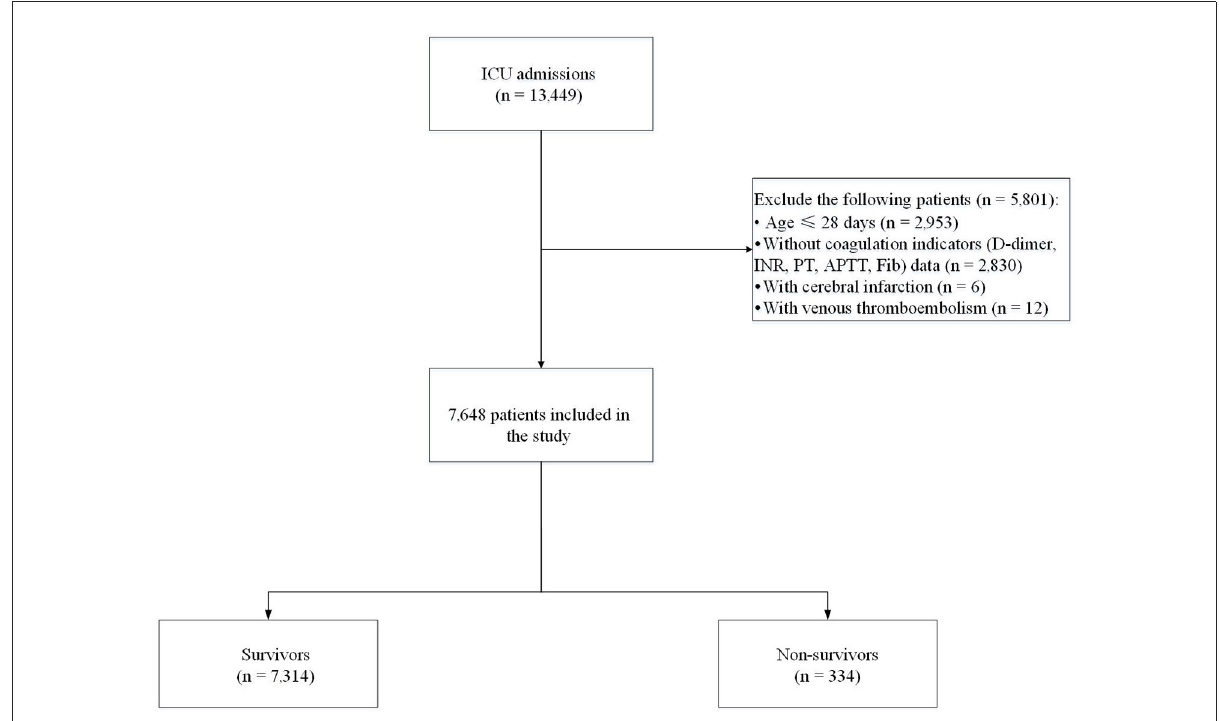
FIGURE1 Flow chart of recruitment of the study population. ICU, intensive care unit; INR, international normalized ratio; PT, prothrombin time; APTT, activated partial thromboplastin time; Fib,